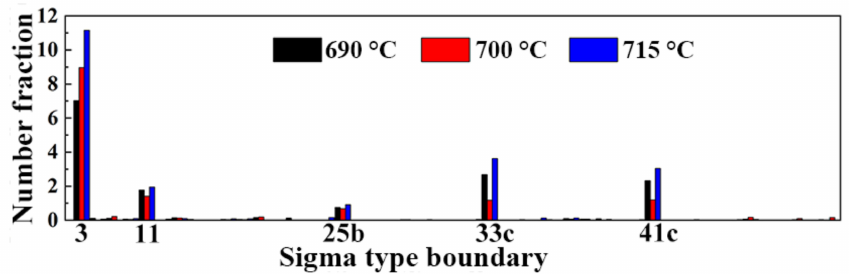
Figure 9. CSL map histograms of the 0.5Cr0.4W steels with different tempering